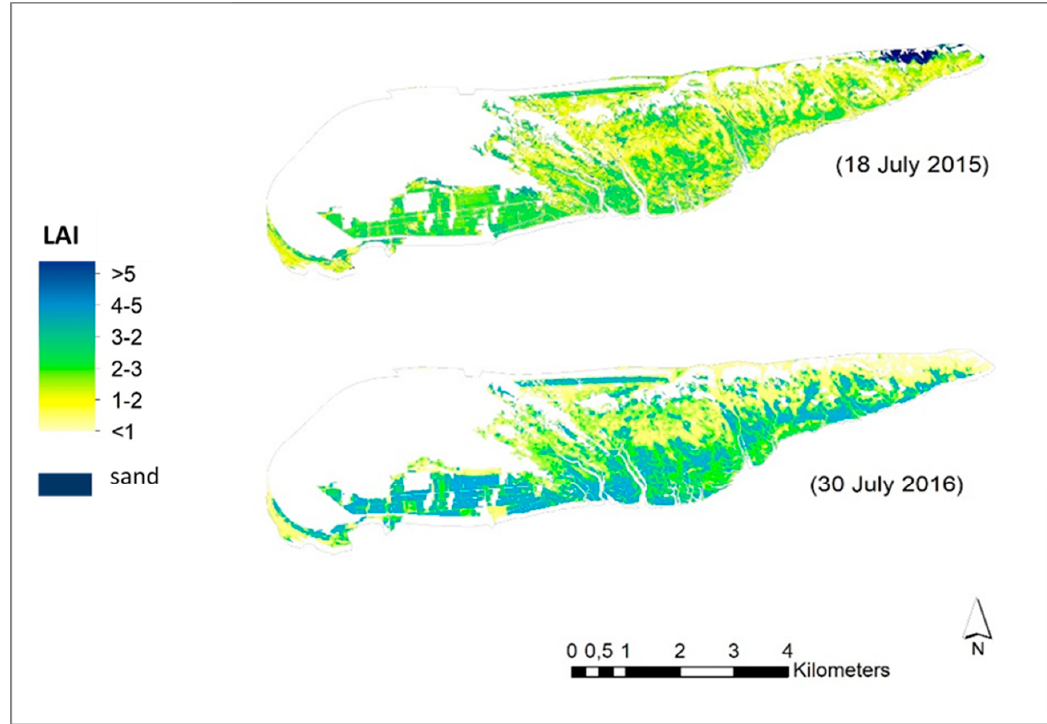
Figure 8. Spatial distribution of LAI in Schiermonnikoog island, the Netherlands. The maps are produced through inversion of PROSAIL using best fitting spectra from RapidEye (2015) Sentinel-2 (2016) images,